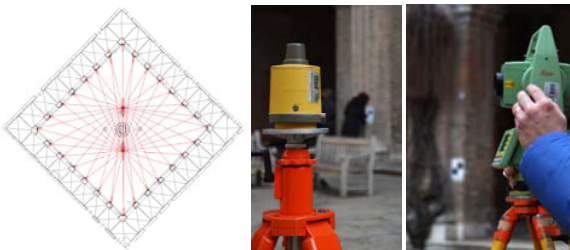
Figure 5. The topographic measures (on the left) and the used instruments (on the right).